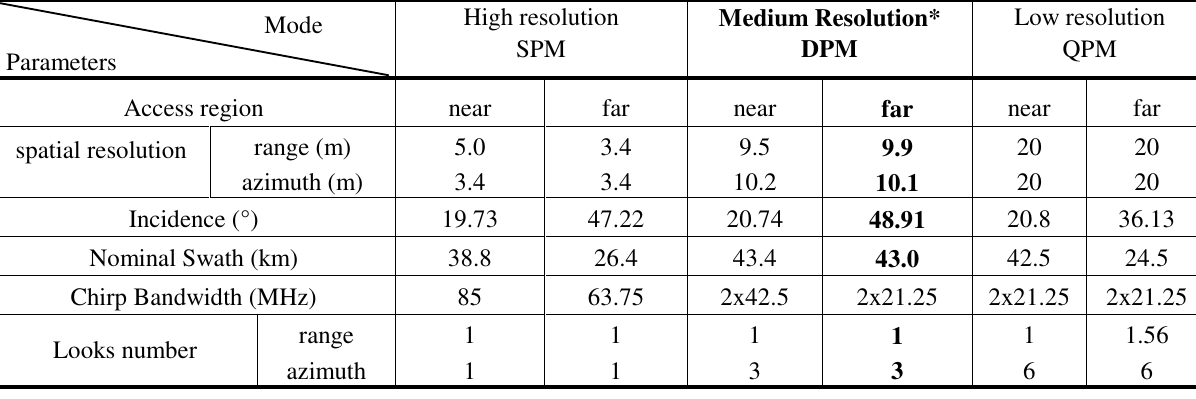
Table 1. Specification of MAPSAR imaging modes.